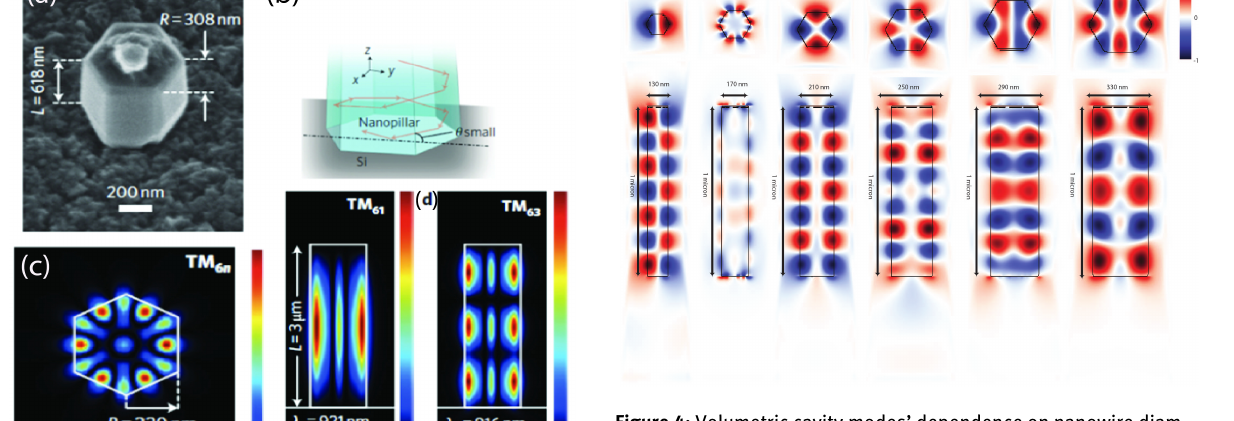
Figure 4: Volumetric cavity modes’ dependence on nanowire diam- eter. Top row is a radial cut at the middle of the wire, bottom row is the corresponding axial spatial variation.